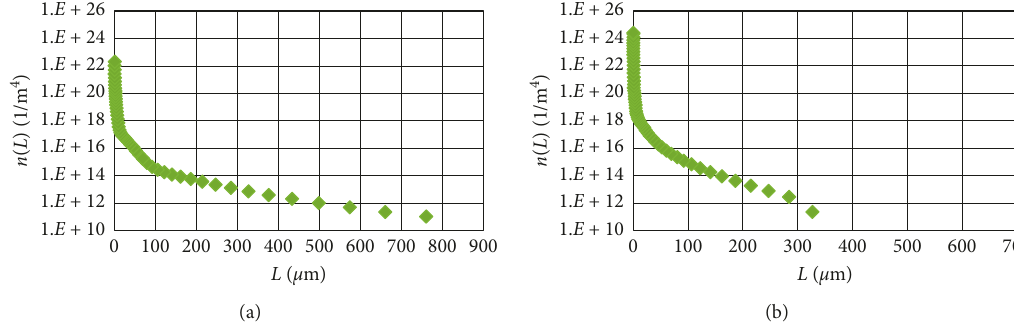
Figure 12: Population density n